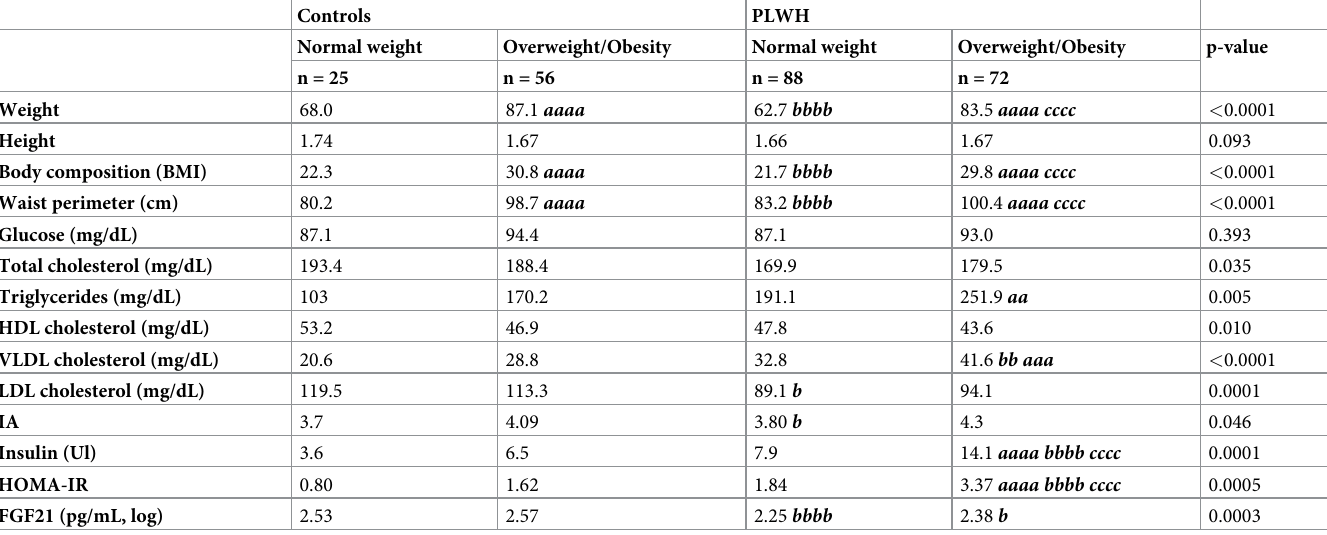
Table 2. Clinical and biochemical parameters in PLWH and HIV-uninfected individuals grouped by BMI classification. Controls